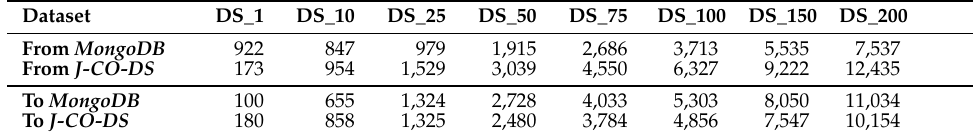
Table 6. Performance comparison between MongoDB and J-CO-DS